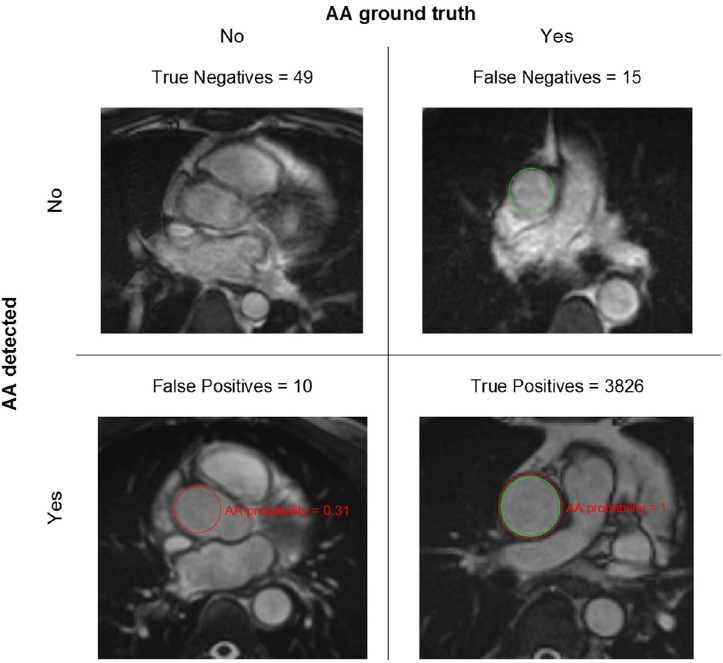
Fig 8. Confusion matrix for AA detection (with example images). Mean error = 0.64% (CI = 0.54–0.74%) estimated from RF training repetitions. Green circles represent the ground truth and red circles the automatically detected ROIs. Total number of scans in the test dataset =